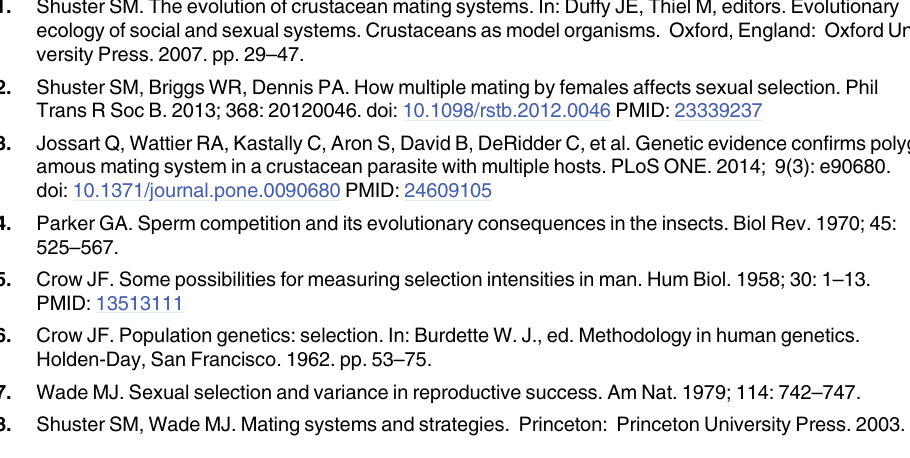
S1 Table. Mating System Parameters for Dissodactylus primitivus .